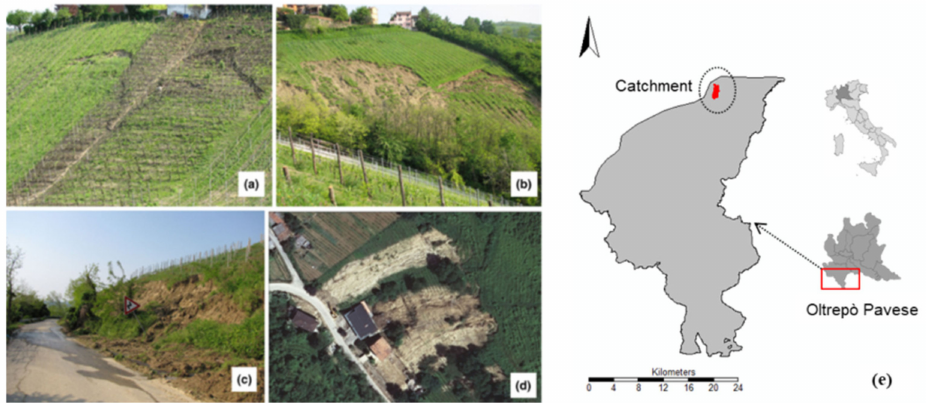
Figure 4. ( a – d ) Examples of landslide in the study area [70]; ( e ) catchment within Oltrep ò Pavese